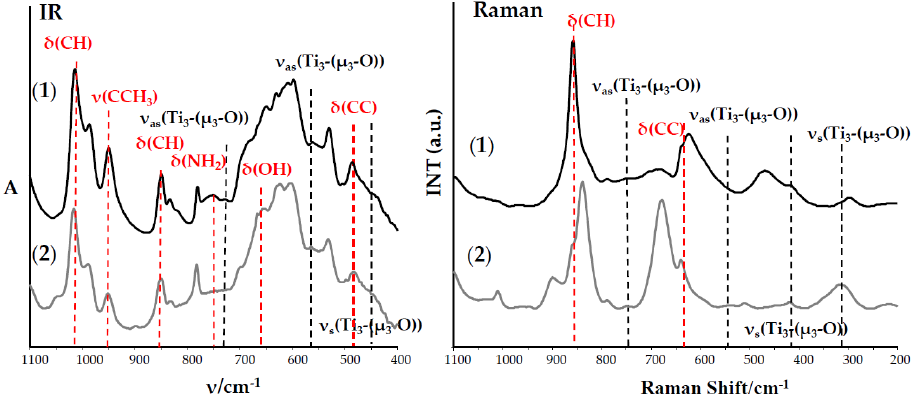
Figure 1. IR and Raman spectra of the ( 1 ) and ( 2 )